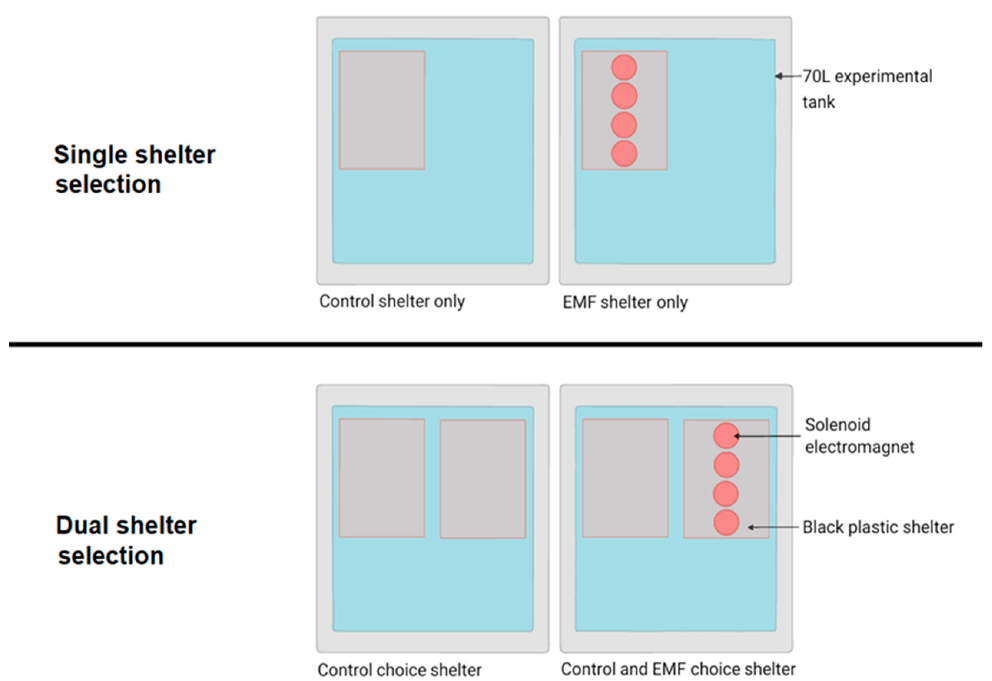
Figure 1. The four shelter experimental designs showing single shelter selection ( top ) and dual choice shelter selection ( bottom ) layouts. EMF (right, magnets powered) and corresponding controls (left, magnets unpowered).